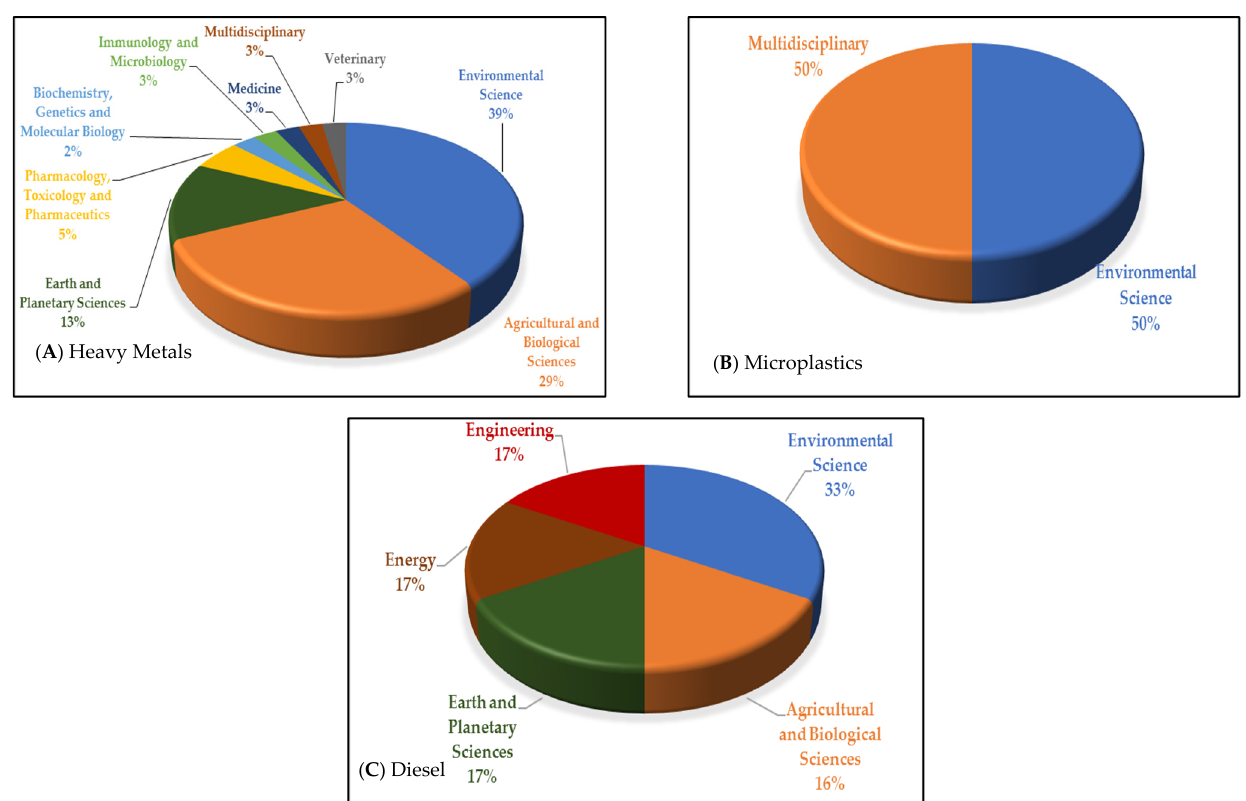
Figure 5. Top subject areas on the research of heavy metals ( A ), microplastics ( B ) and diesel ( C ) pollution and their effects on penguins indigenous to Antarctica.